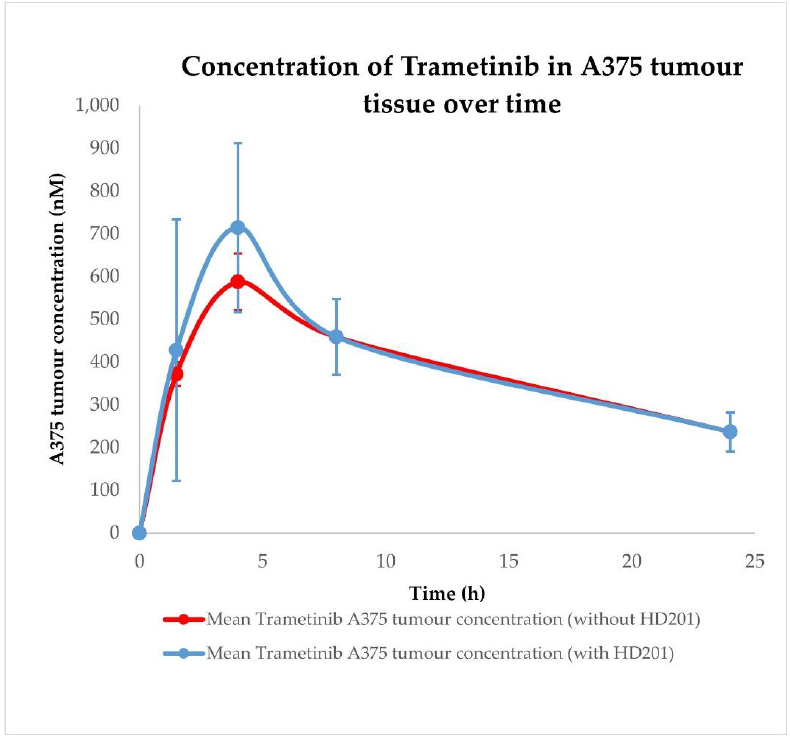
Figure 8. Pharmacokinetic profiles of Trametinib in A375 tumour tissue after administration with and without HDM201. Observed data are means ± standard deviation (SD) from n = 3.